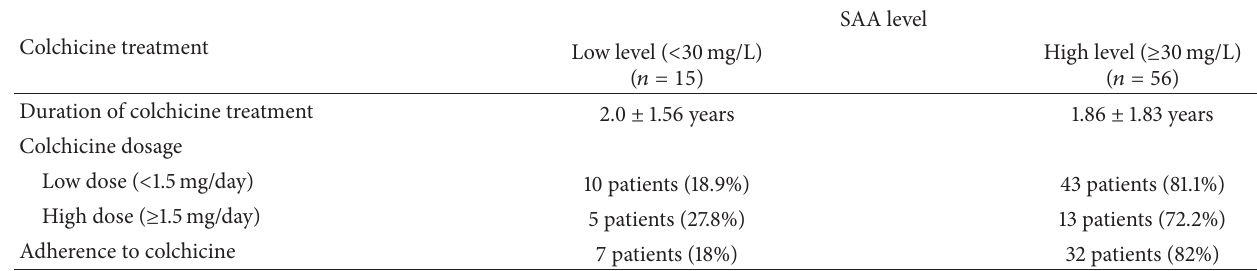
Table 4: Correlation between colchicine treatment and SAA